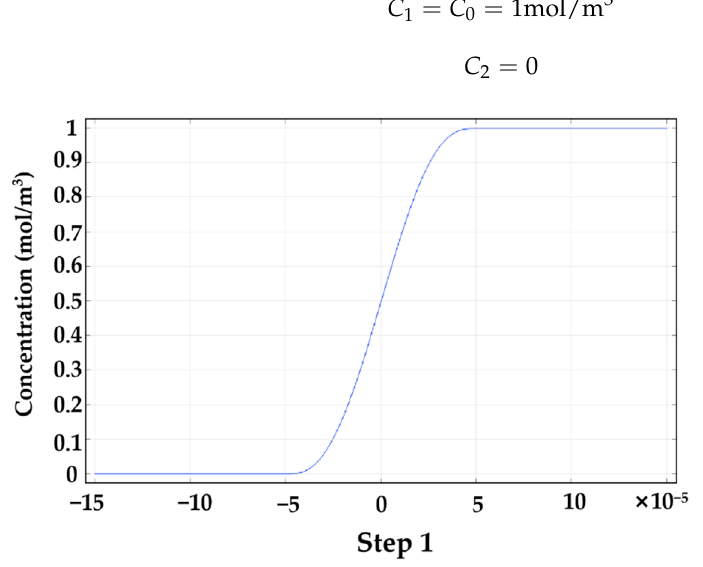
Figure 2. The step function of the concentration distribution on the microchannel inlet. In our simulation, the identical fluid velocity of inlet 1 and inlet 2 was selected as U 0 = U inlet1 = U inlet2 = 0.1 mm/s. The constant flow velocity and zero fixed pressure boundary condition at the outlet were specified. The no-slip boundary condition was assigned at the microchannel